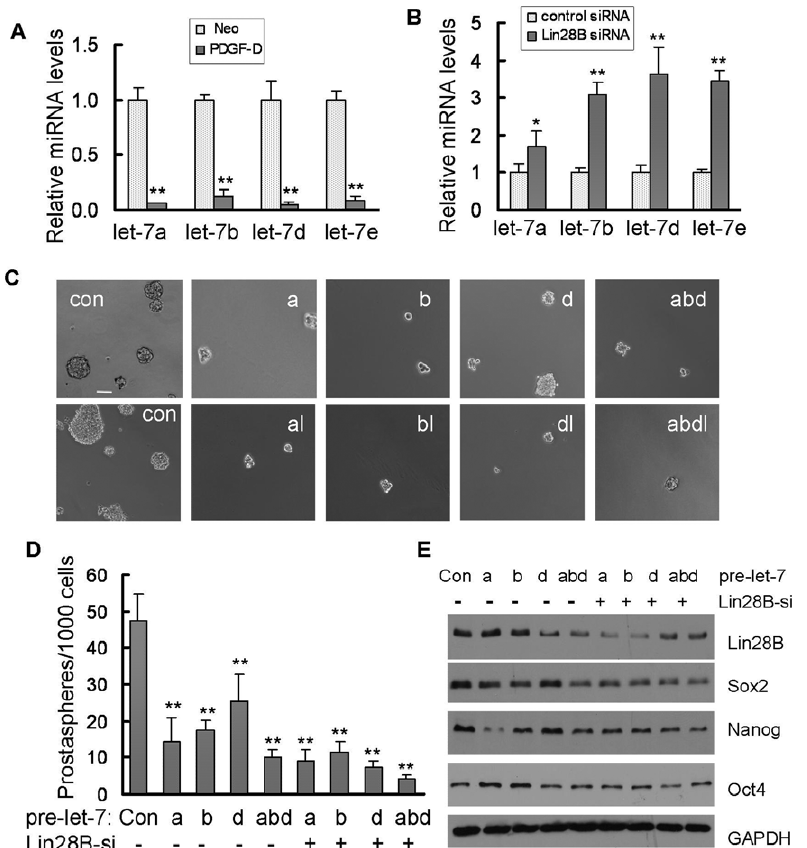
Figure 6. Lin28B-mediated repression of let-7 was partially responsible for regulating self-renewal in PC3 PDGF-D cells. (A) The levels for let-7 family in PC3 Neo and PC3 PDGF-D cells were determined by using real time RT-PCR. (B) Real time RT-PCR was used to quantify the expression of let-7 in PC3 PDGF-D cells transfected with Lin28B siRNA for 3 days. (C) Photomicrographs showing prostaspheres generated from PC3 PDGF-D cells transfected with pre-let-7 or combination of pre-let-7 and Lin28B siRNA 14 days after transfection (bar:100 m m). (D) The cells were collected for prostasphere-forming assay after 14-day transfection. Let-7a, let-7b, let-7d and combination of Let-7a, let-7b, let-7d as well as co- transfection with let-7 and Lin28B siRNA decreased the number of prostaspheres. (E) The results from Western blot showed the expression of Lin28B, Sox2, Nanog, and Oct4 in PC3 PDGF-D cells transfected with pre-let-7 or co-transfected with pre-let-7 and Lin28B siRNA after 9-day transfection. *, p , 0.05 compared to control; **, p , 0.01 compared to control. (Con: control, a: pre-let-7a, abd: combination of pre-let-7a, pre-let-7a, pre-let-7d, al: combination of pre-let-7a and Lin28B siRNA, Lin28B-si: Lin28B siRNA, Neo: PC3 Neo cells, PDGF-D: PC3 PDGF-D cells).